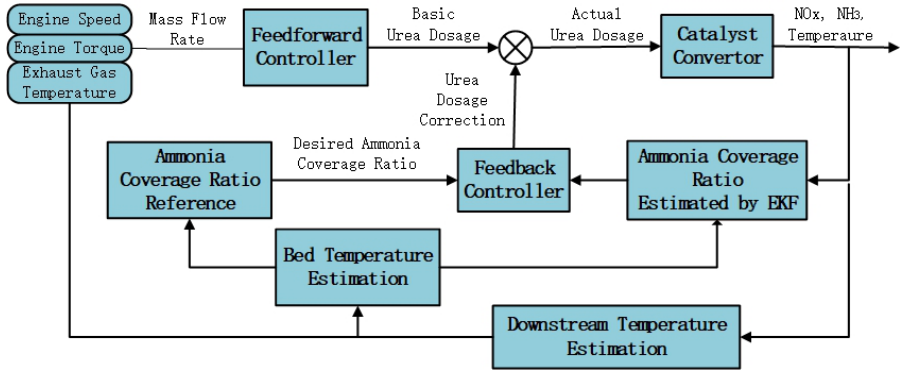
Figure 7. Fault-tolerant control strategy of SCR system.